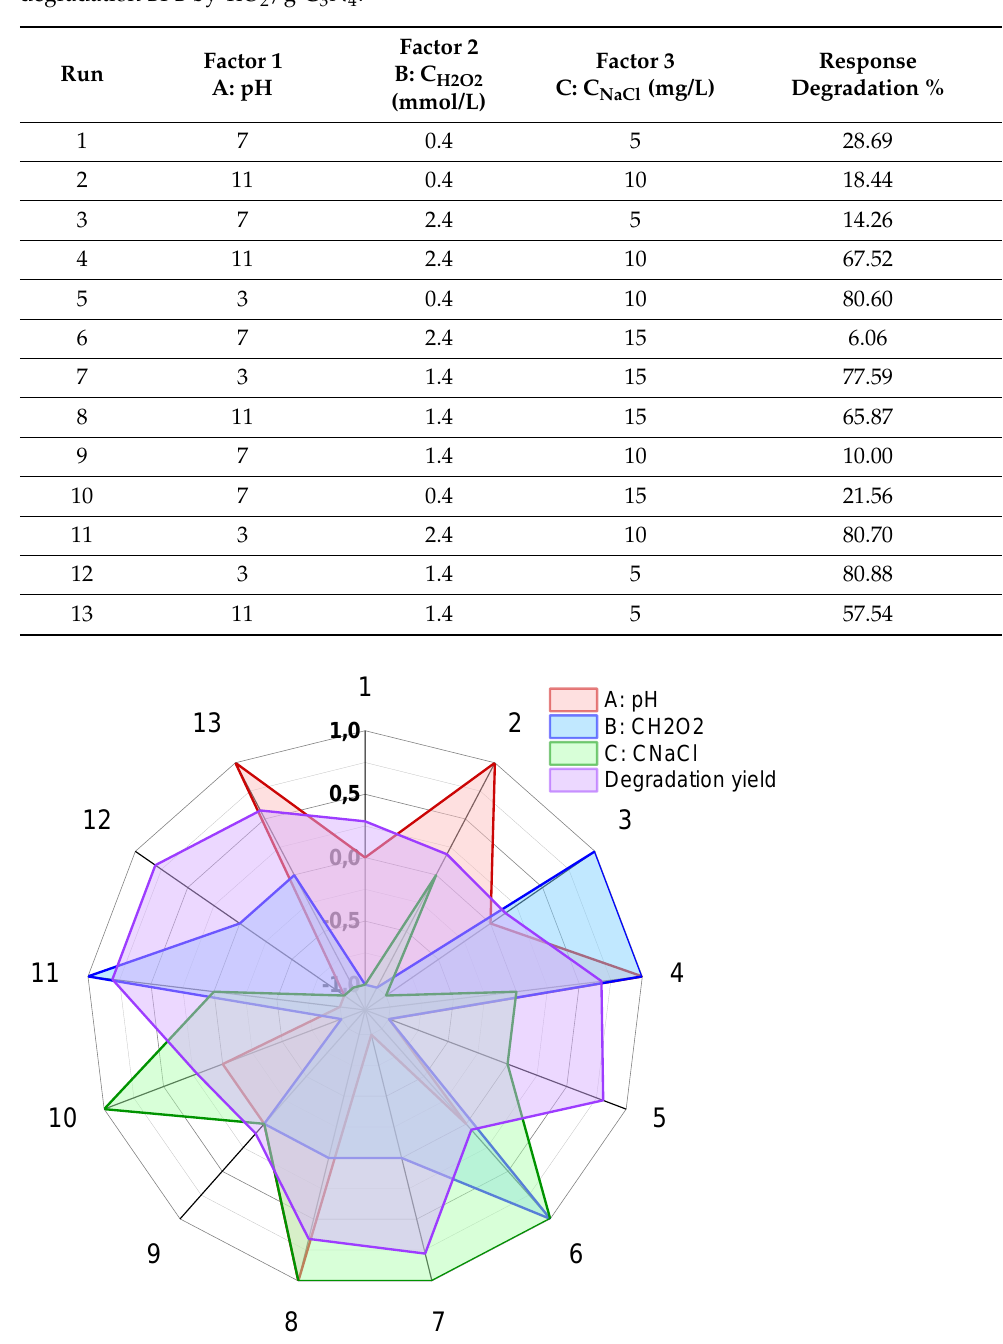
Figure 11. Spider graph visualization of experimental design results for the mutual effects of pH, NaCl, and H 2 O 2 on photocatalytic degradation BPB by TiO 2 /g-C 3 N 4 .